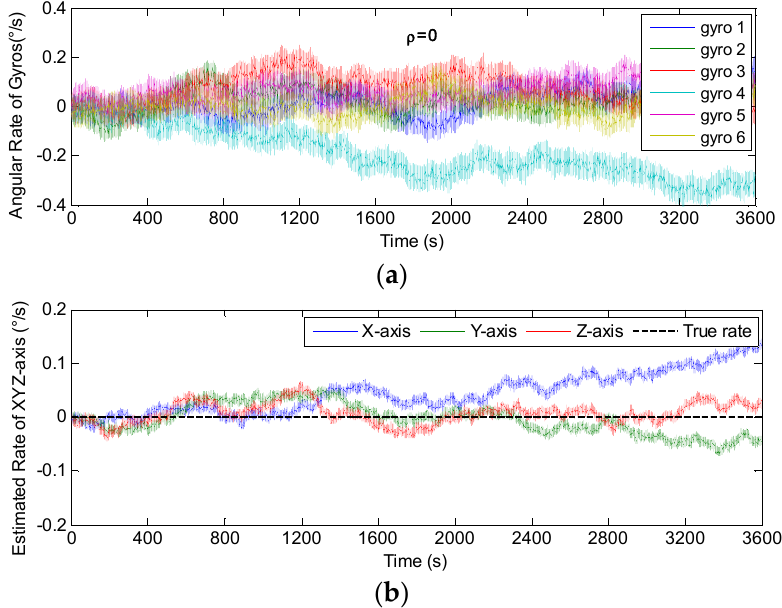
Figure 11. Fused results of the 6-gyro MIMU system for scheme 1 ( ρ = 0). ( a ) The output of gyros. ( b ) The estimated result of the MIMU.